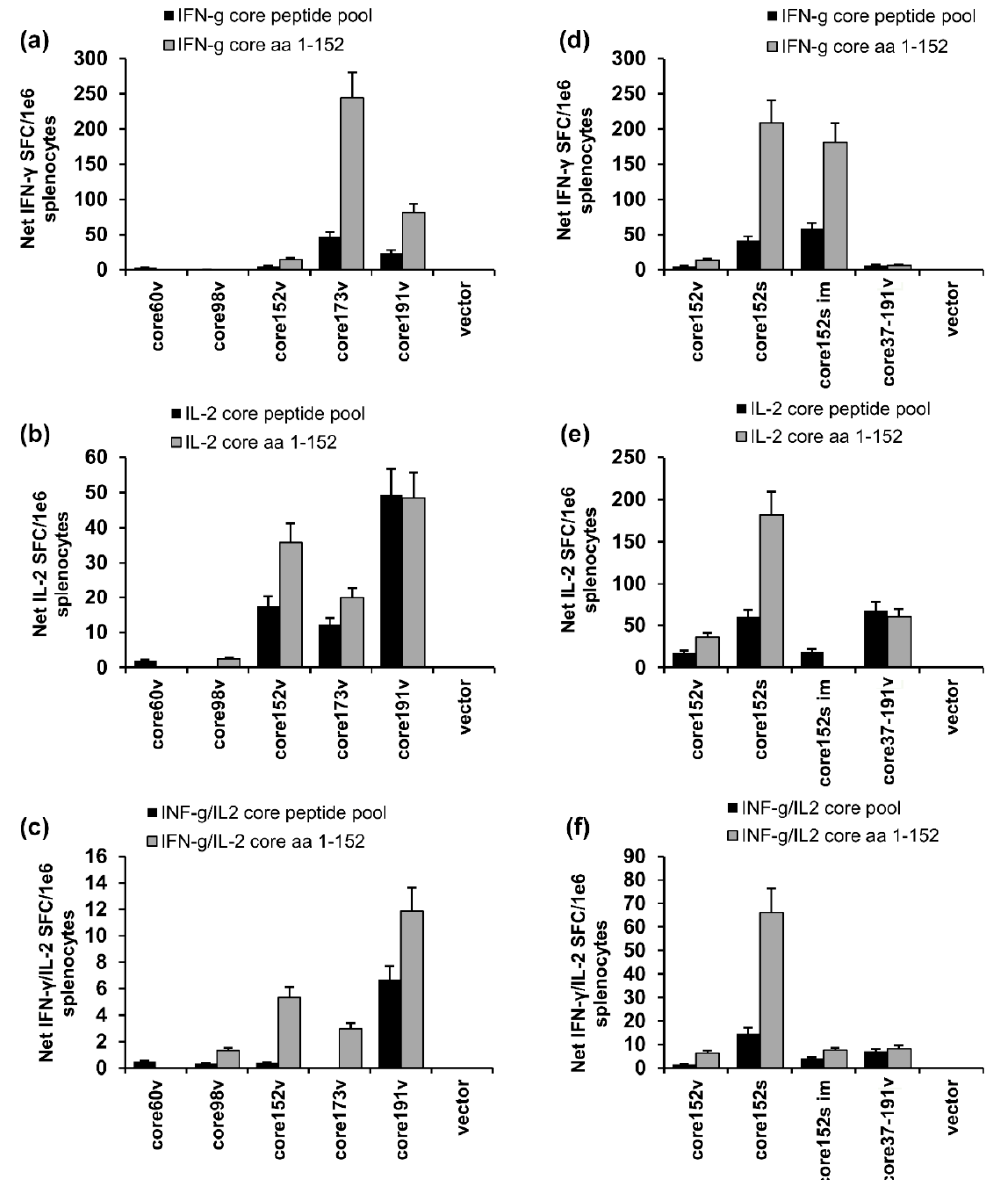
Figure 5. Cellular immune response of BALB/C mice to DNA-immunization with HCV core gene variants delivered by intradermal injections followed by electroporation. Comparison of the results of independent intradermal DNA-immunization/EP with core60v, core98v, core152v, core191v, core37-191v, and empty vector ( a – c ); or core37-191v, core152 encoded by DNA of viral (core152v) versus synthetic origin (core152s), also delivered by im injection without EP (core152s im) and empty vector DNA ( d , e ). Graphs show cytokine secretion of mouse splenocytes in response to in vitro stimulation with core-derived peptide pool and recombinant core152 represented as the number of spot forming cells per mln splenocytes producing IFN- γ (A, D); IL-2 ( b , e ); and both cytokines ( c , f ) assessed by IFN-g/IL-2 Fluorospot. All assays were done in duplicates. Results represent average values for all mice in the group ± SD. The specific responses exceeded three-times the secretion of respective cytokines in response to stimulation with an unrelated control peptide. No difference between the groups was registered in response to stimulation with the mitogen ConA ( p > 0.05; data not shown).